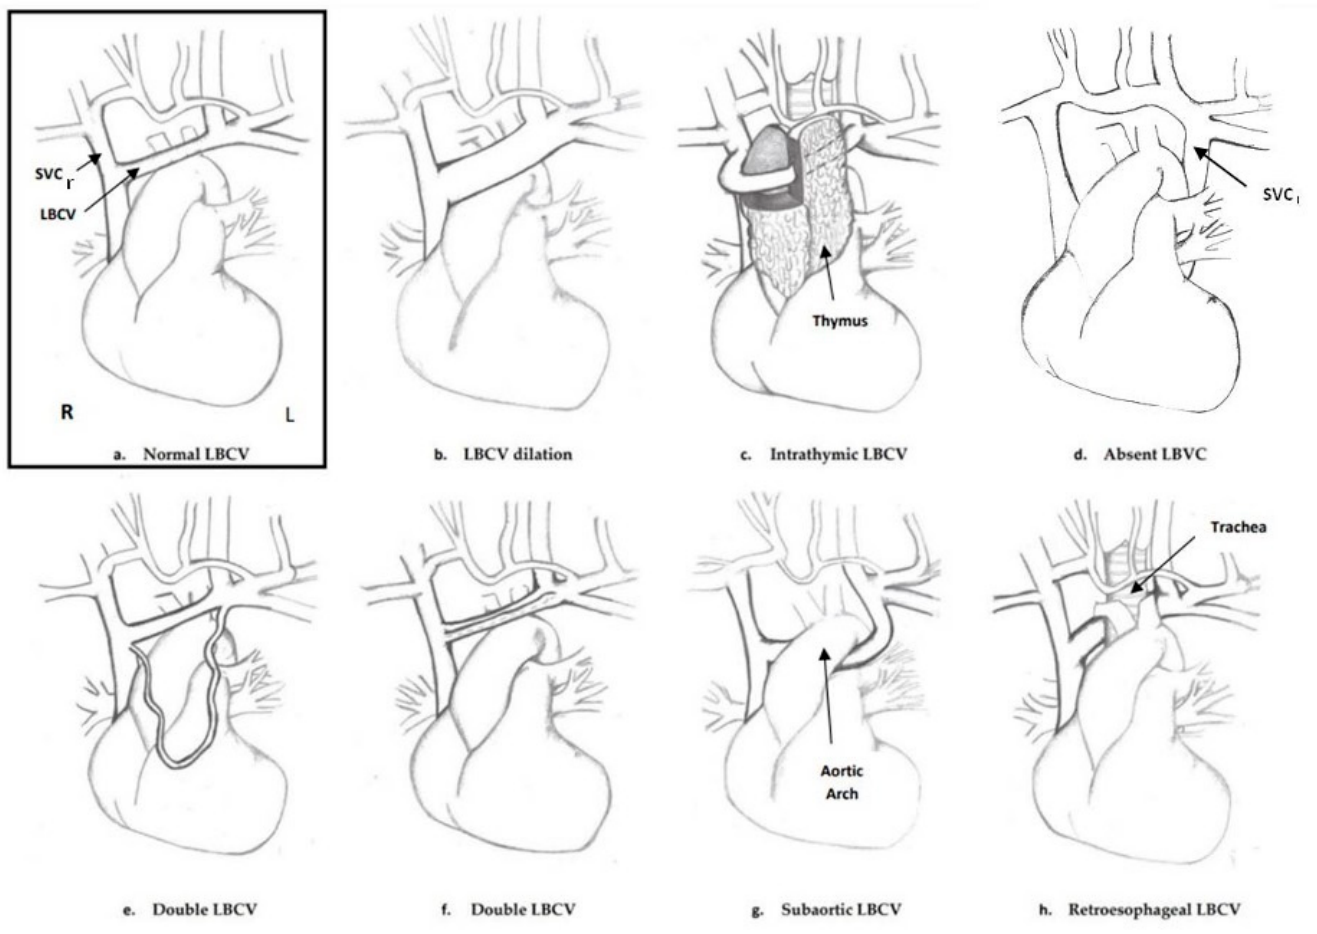
Figure 3. Illustration of the normal left brachiocephalic vein (LBCV) anatomy and LBCV anomalies: ( a ) normal LBCV; ( b ) dilated LBCV; ( c ) intrathymic LBCV; ( d ) absent LBCV with a persistent left superior vena cava (LSVC); ( e , f ) double LBCV; ( g ) subaortic LBCV; ( h ) retroesophageal LBCV. SVCr = right superior; SVC l = persistent left superior vena cava.